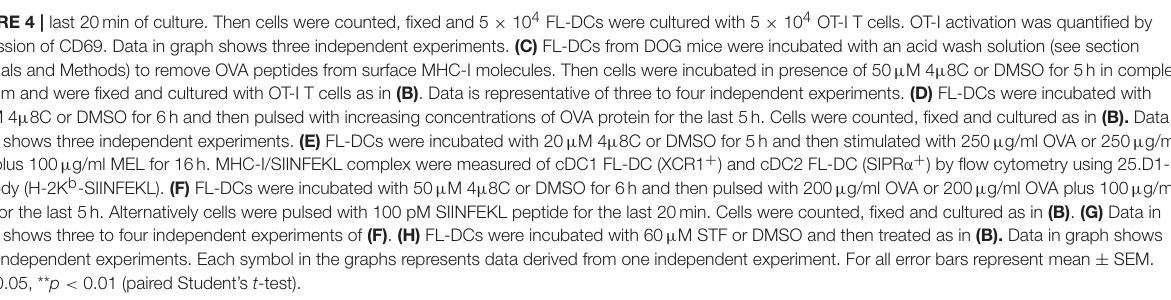
constitutive expression of cytosolic OVA protein in DCs